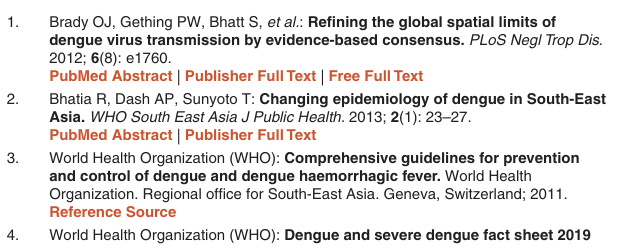
Figshare: Nwe Ni Linn et al 2020 dataset v2. https://doi.org/10.6084/ m9.figshare.12355958.v1